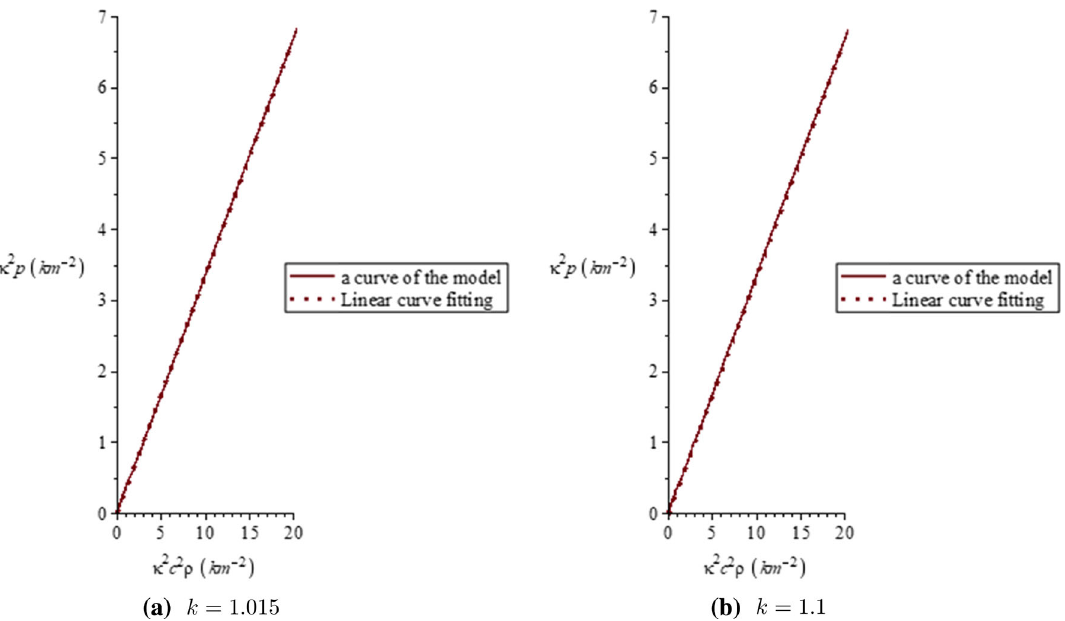
Fig. 7 The pressure versus energy density inside the star for r b = 10 km , and α = 3. The solid curves in ( a ) and ( b ) represent the relation between p and ρ from (49) and (50) and the dotted curves represent the equation of state p = ρ